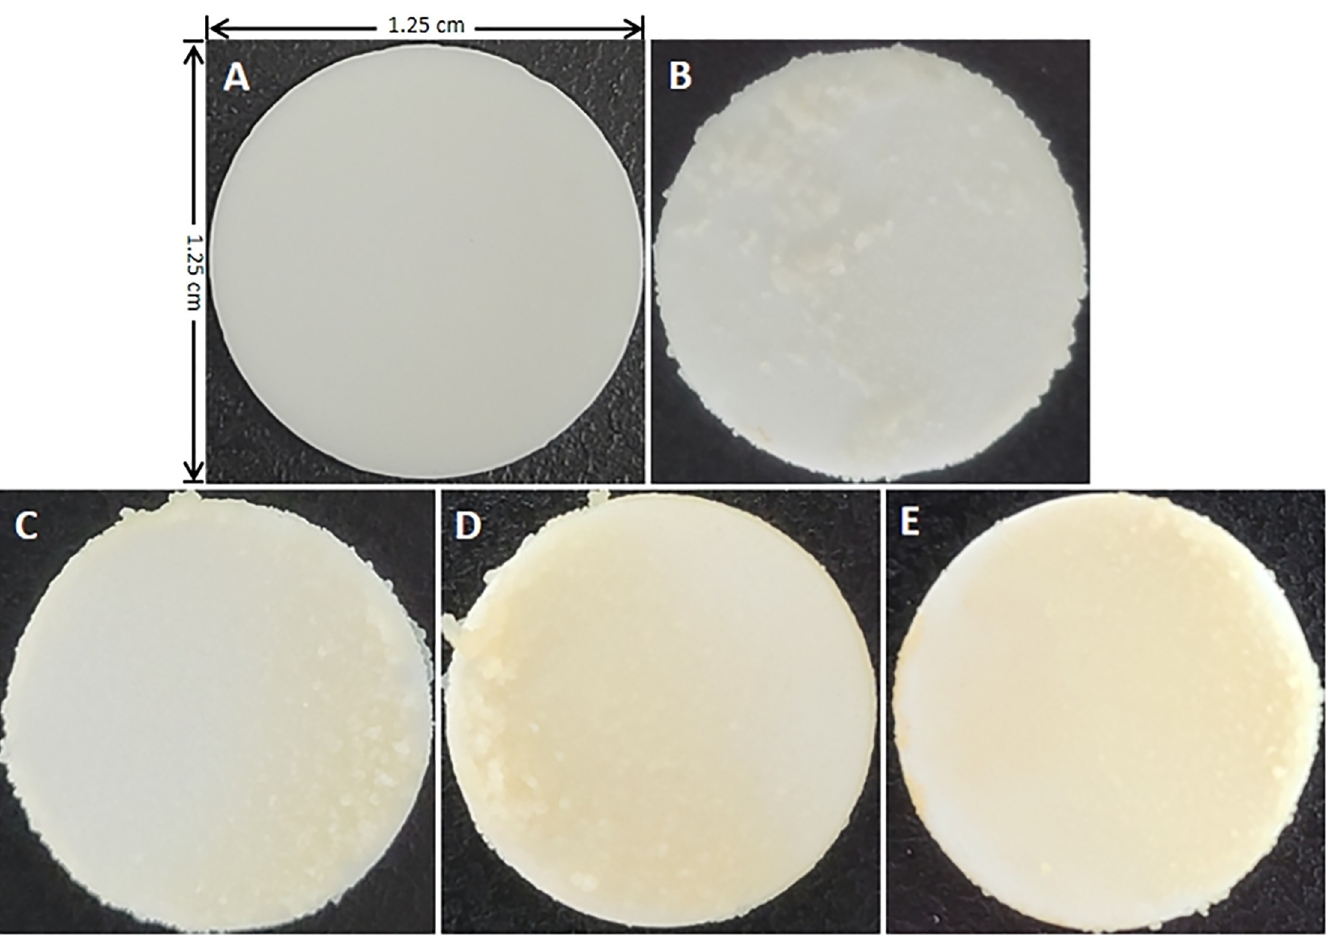
Fig 8. Surface morphology of hydroxyapatite disks before the experiment and each group after 74-h-old incubation. ( A ) Before the experiment. ( B ) Control group. ( C ) 1 time/day CS exposure group. ( D ) 3 times/day CS exposure group. ( E ) 6 times/day CS exposure group.